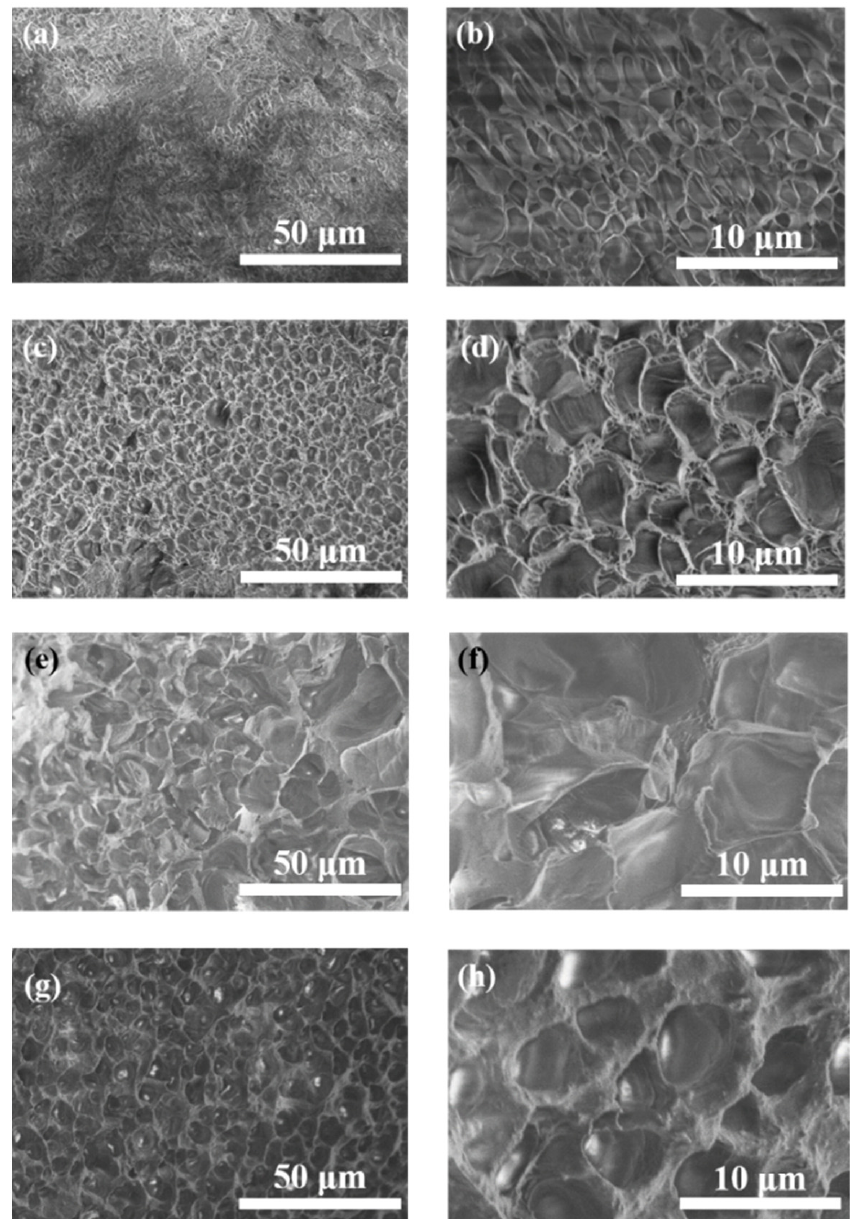
Figure 3. SEM images of ( a , b ) G SN gel, ( c , d ) PAM SN gel, ( e , f ) G/PAM DN gel and ( g , h ) M 3 /G/PAM NDN gel.